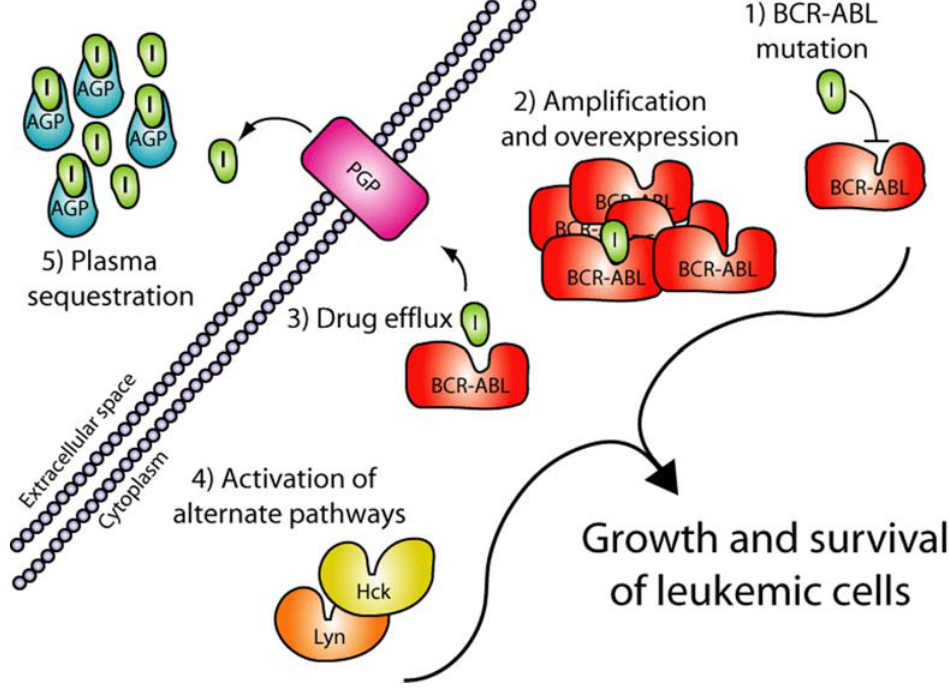
FIGURE 1. Mechanisms of imatinib resistance in CML. Clinical imatinib resistance is mediated primarily by (1) kinase domain mutation preventing imatinib from binding. (2) Genomic amplification and protein over expression of BCR-ABL has also been demonstrated in patients resistant to imatinib. Other mechanisms may include (3) drug efflux mediated by Pgp expression, (4) activation of alternate signaling pathways including the Src-family kinases Lyn and Hck, and (5) plasma sequestration by imatinib-binding proteins such as AGP. All mechanisms include the final common pathway of tyrosine kinase activity, promoting growth and survival of the leukemic cells. Imatinib is depicted as a green oval